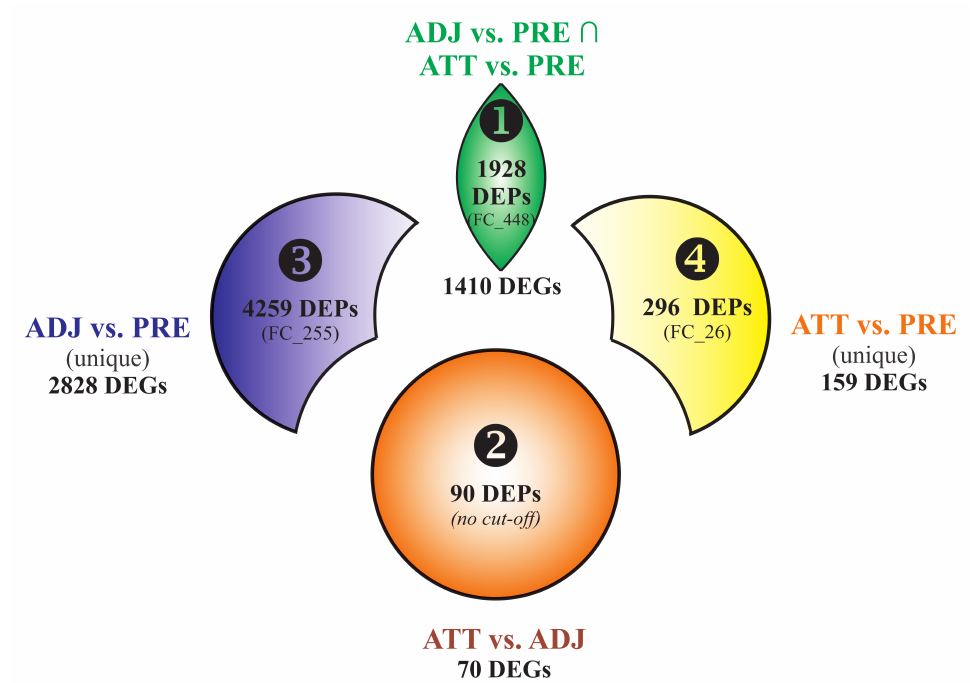
Figure 2. Venn diagram showing di ff erentially expressed probes (DEPs) and / or genes (DEGs) among di ff erent segments considered in the Results and Discussion Sections. Each segment is assigned with a number (1–4). Bold numbers indicate the DEPs contributing to a particular segment. The number of DEGs corresponding to DEPs of each segment is shown. FC_# indicates the number of DEPs with a fold-change ≥ | 2 | . It should be noted that DEPs in segment 1 required to comply with the criteria of FC ≥ | 2 | in both comparisons ADJ versus PRE and ATT versus PRE. Only the features with FC ≥ | 2 | were subjected to Blast2GO enrichment analyses, except for segment 2 as this probe list was relatively shorter. Whereas, all the DEGs of each segment were used in gene ontology (GO) / pathway terms analyses using ClueGO. vs.,